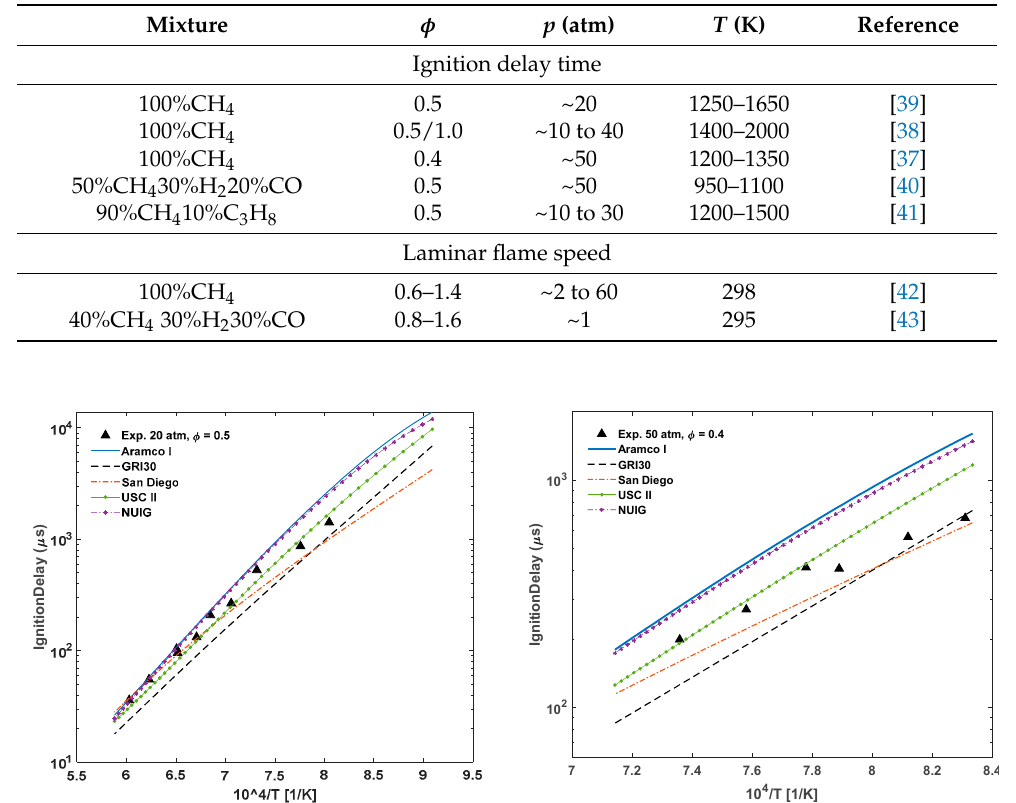
Table 3. Experimental conditions for the ignition delay time and laminar flame speed simulation of CH 4 , CH 4 /H 2 /CO, and CH 4 /C 3 H 8 mixtures at high pressures reported in the literature.